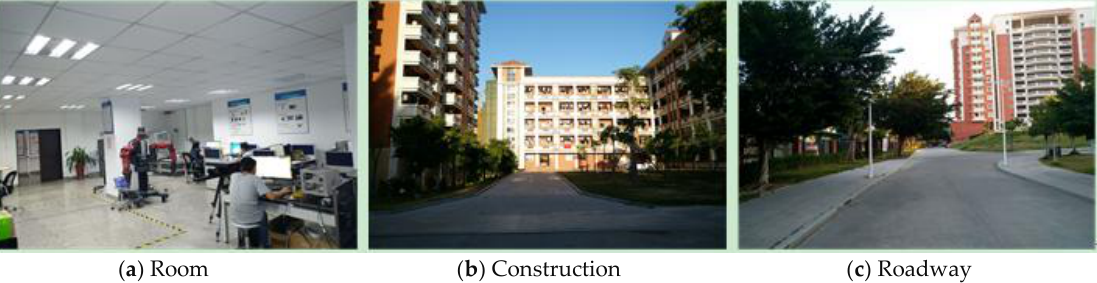
Figure 8. Three typical scenarios (room, construction, and roadway) were adopted to capture the 3D point clouds.